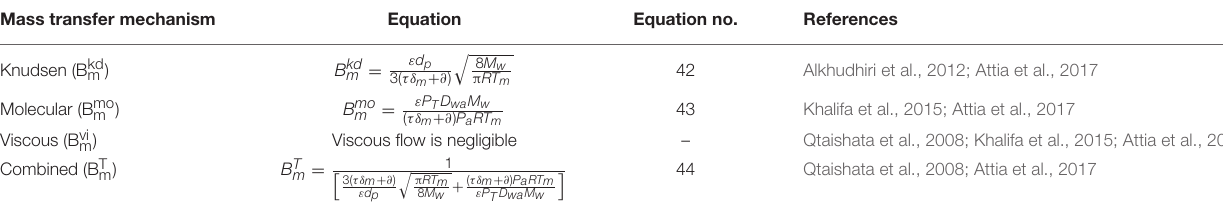
TABLE 6 | Mass transfer mechanisms in AGMD and